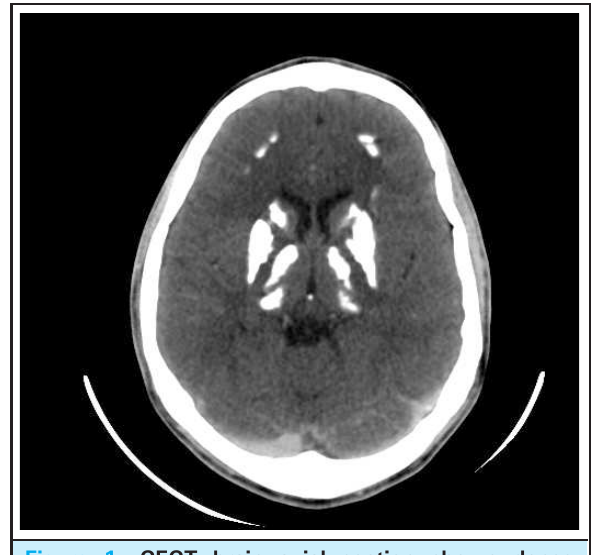
Figure 1. CECT brain axial section shows dense calcification in head of caudate nucleus, basal ganglia, thalamus and frontal